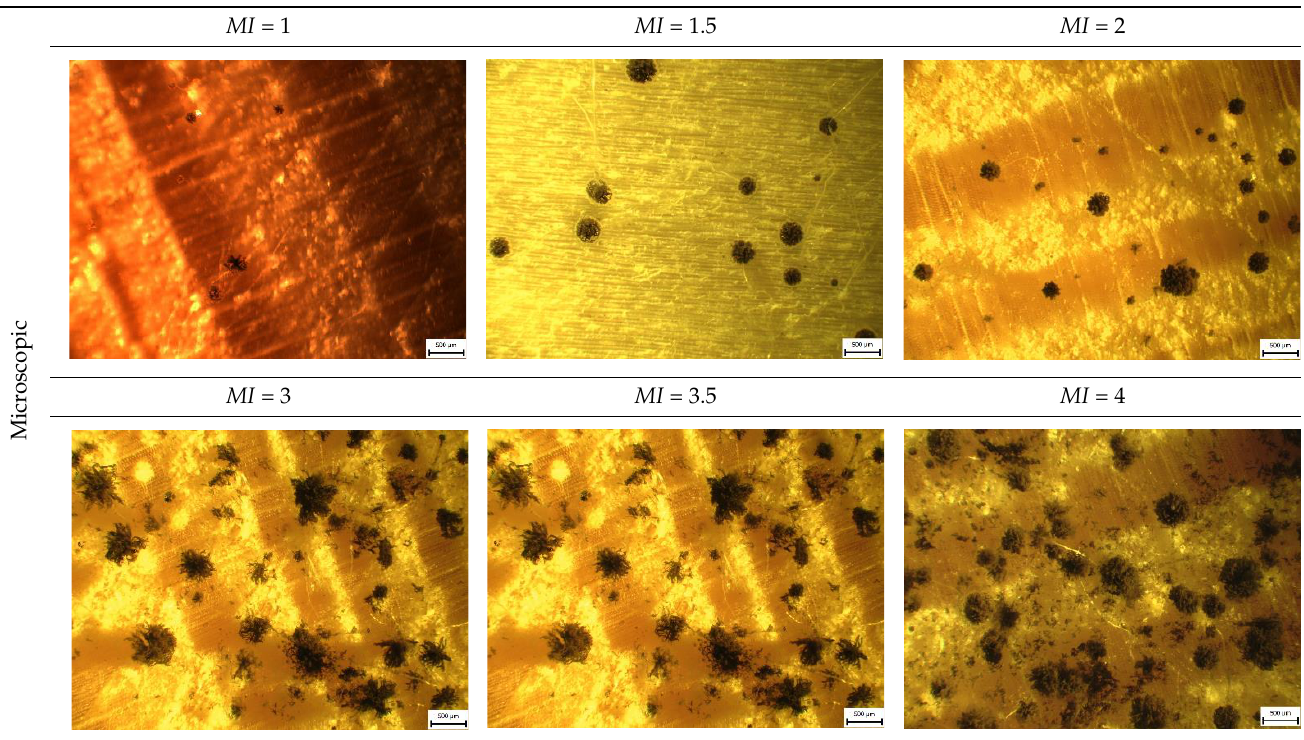
Table 3. The scale of mold index and subindex (according to Table 2) exemplified by microscopic and macroscopic photographs.